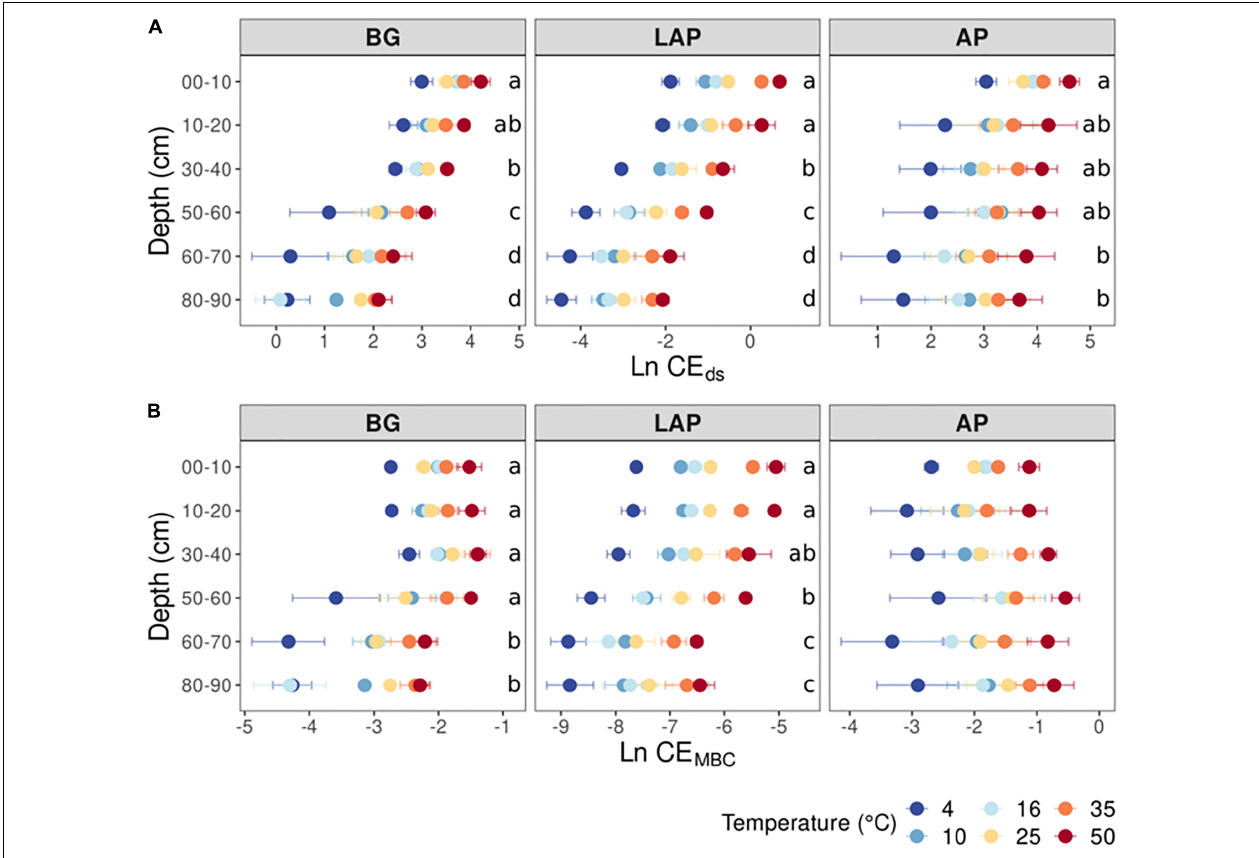
FIGURE 3 | Enzyme catalytic efficiency at different depths and six temperatures from 4 to 50 ◦ C, calculated on a (A) dry soil mass basis (CE ds ), or a (B) microbial biomass C basis (CE MBC ). Two-way ANOVA with depth and temperature as interactive factors indicated that both depth and temperature had a significant effect on CE ds and CE MBC of all enzymes ( p < 0.05), except for no effect of depth on CE MBC of AP ( Table 3 ). There was no depth × temperature effect. Colors indicate incubation temperatures and letters indicate significant differences ( p < 0.05) between depths per enzyme, based on Tukey’s tests after ANOVA tests. Error bars represent the standard error of the mean ( n =